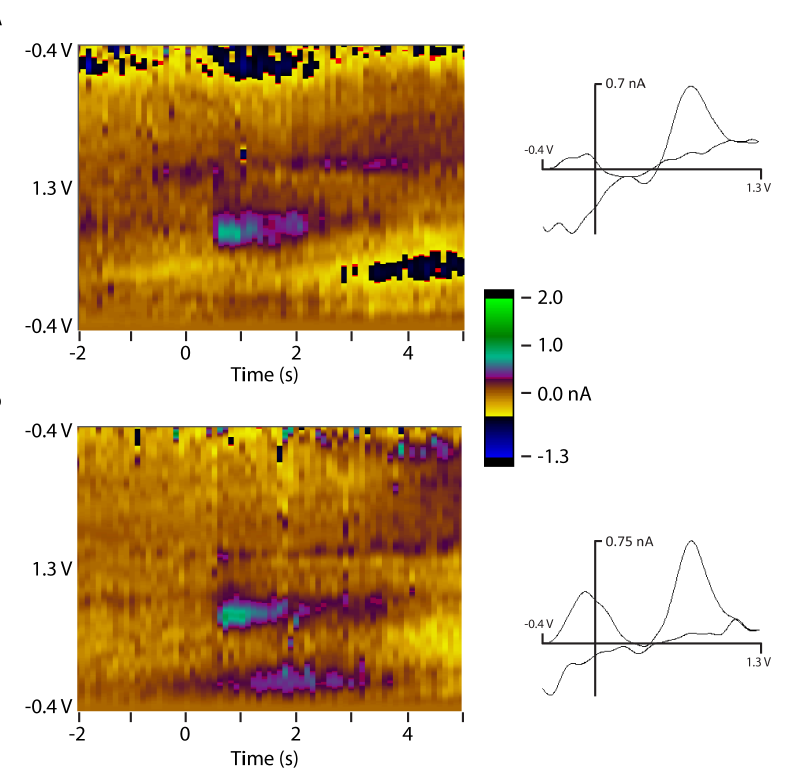
Figure 10. Reward related DA release in the ventral striatum. Triplets of juice rewards were delivered unexpectedly to monkey B, repeated 15 times over the course of 98 min. Carbon fiber electrode was at AP 21, ML 3.0, EBZ 16.1 (relative to ear bar zero, see [25]). Small, but constant dopamine responses occurred with every triplet. Example color plot and accompanying cyclic voltammograms for unexpected juice triplets delivered (A) 69.5 min after the first juice delivery and (B) 30 s later. Dopamine oxidation peaks are about 0.82 V.